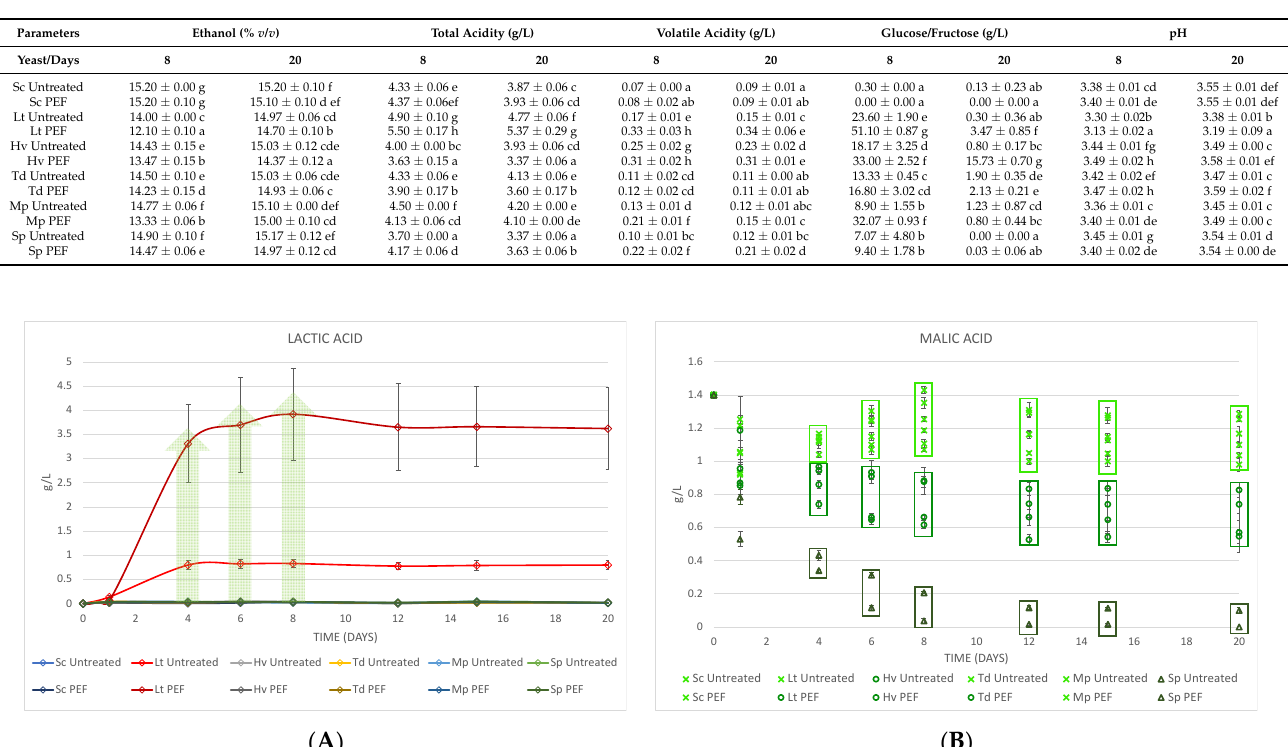
Table 2. Oenological parameters of the different fermentations before sequential inoculation with Sc (day 8) and on the last day of analysis (day 30). Values are means with standard deviations, n = 3. Values with the same letter in the same column are not significantly different ( p < 0.05).